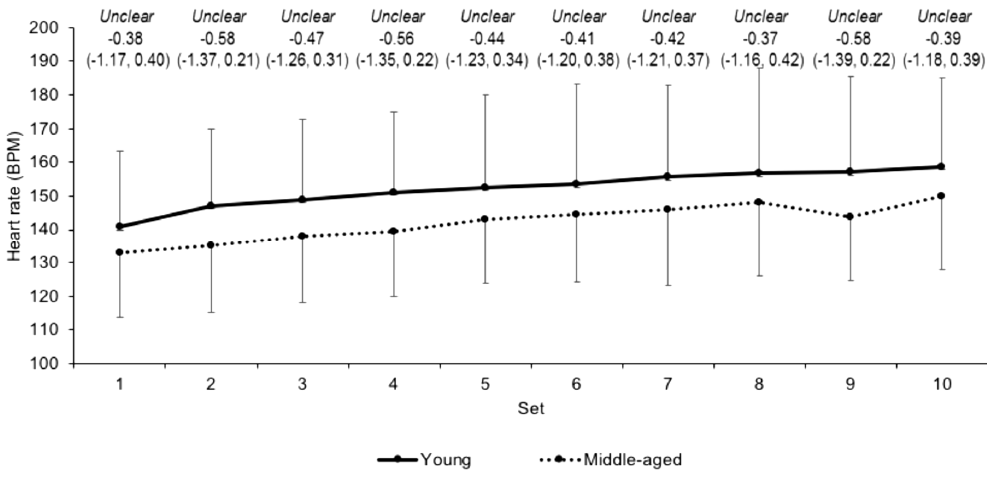
Figure 2. Absolute heart rate scores (mean ± SD) across each set for young and middle-aged groups. Qualitative descriptor, effect size, and upper and lower 90% confidence intervals are noted above.